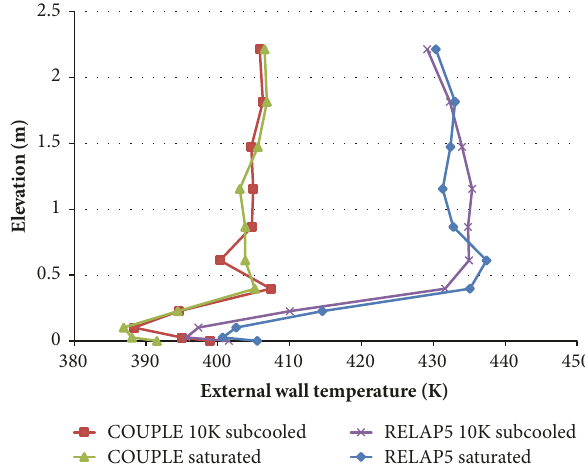
Figure 12: Maximum RPV external wall temperature for each case.